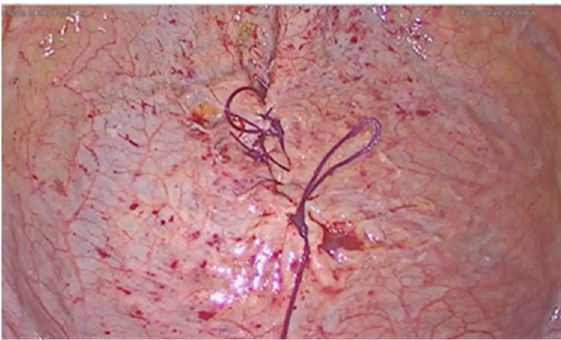
Figure 3. Bladder dome injury, view with vesical catheter.